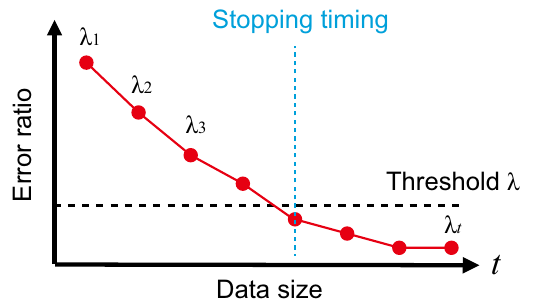
Fig. 2 Schematic of the stopping criterion with the error ratio. The data size increases with measurement time t . The error ratio λ t is evaluated after every Gaussian process regression . The measure- ment is stopped when λ t falls below the threshold λ . The original conceptual diagram appears in ref. 45